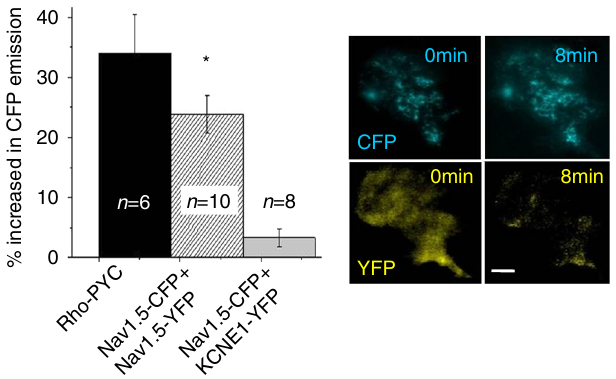
Fig. 4 Na v 1.5 α -subunits still interact at the cell surface. TIRF/FRET imaging of Na v 1.5-CFP co-expressed with Na v 1.5-YFP demonstrate an increase in CFP signal following acceptor (YFP) photobleaching indicating that the two subunits are within 10 nm. Rho-PYC was used as a positive control and cells co-transfected with Na v 1.5-CFP+ KCNE1-YFP were used as a negative control. Scale bar = 10 μ m. Data are presented as mean ± SEM, * p <